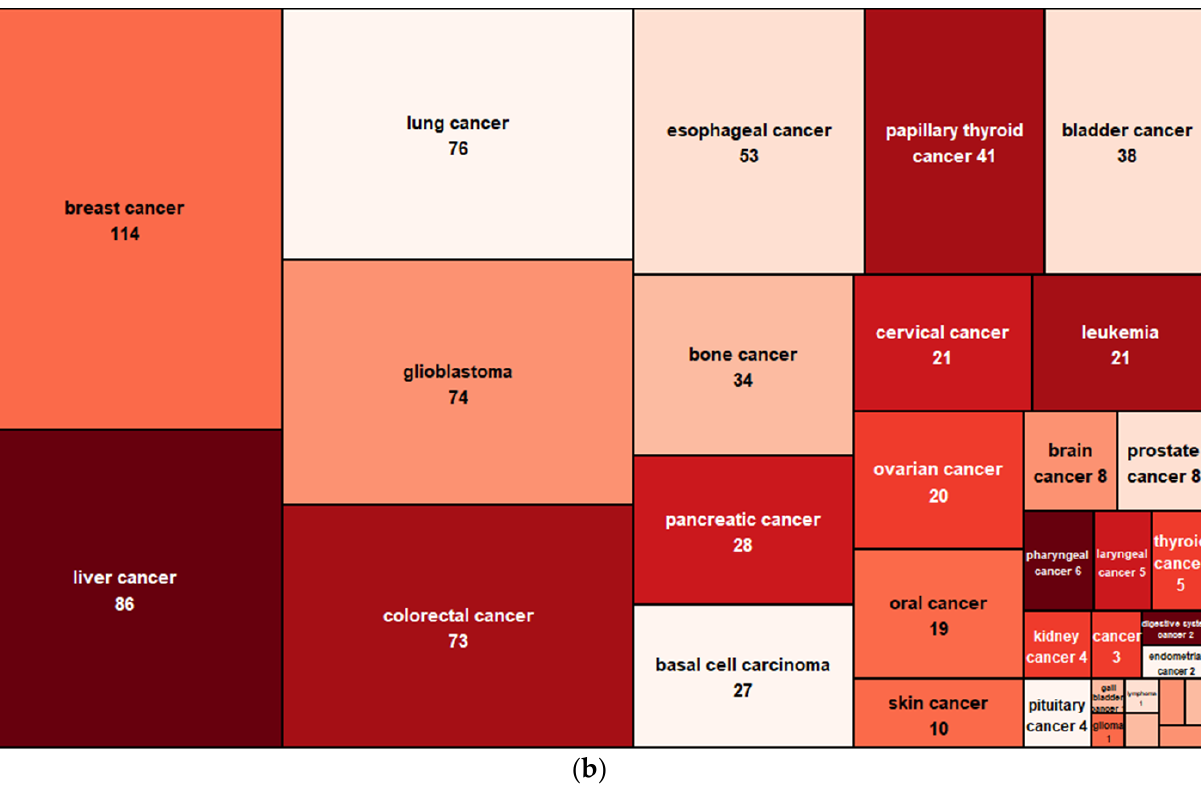
Figure 2. CircRNAs associated with noncancer ( a ) and cancer ( b ) diseases. Data are based on the CirCAD database [10].